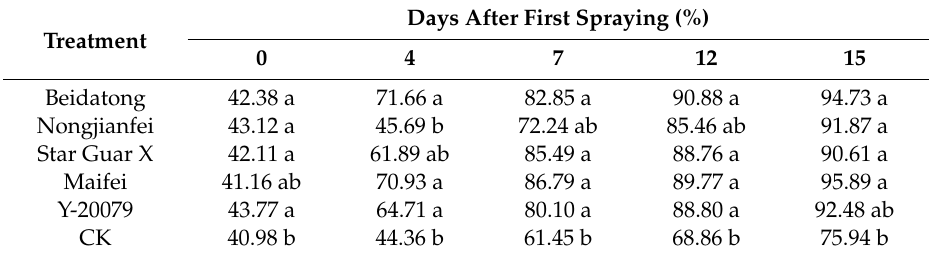
Table 6. Effect of aviation spray adjuvants on cotton boll opening sprayed by UAV. Table 6. E ff ect of aviation spray adjuvants on cotton boll opening sprayed by UAV.